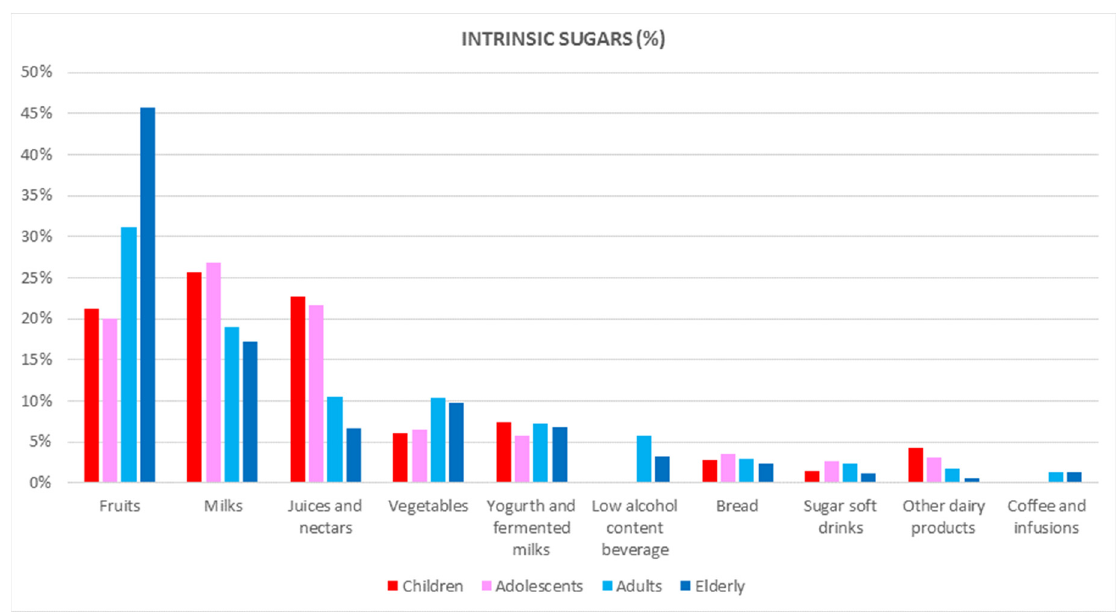
Figure 1. Dietary top 10 food and beverages groups for intrinsic sugars (%) by age group in the ANIBES Study (Anthropometry, Intake and Energy Balance in Spain).